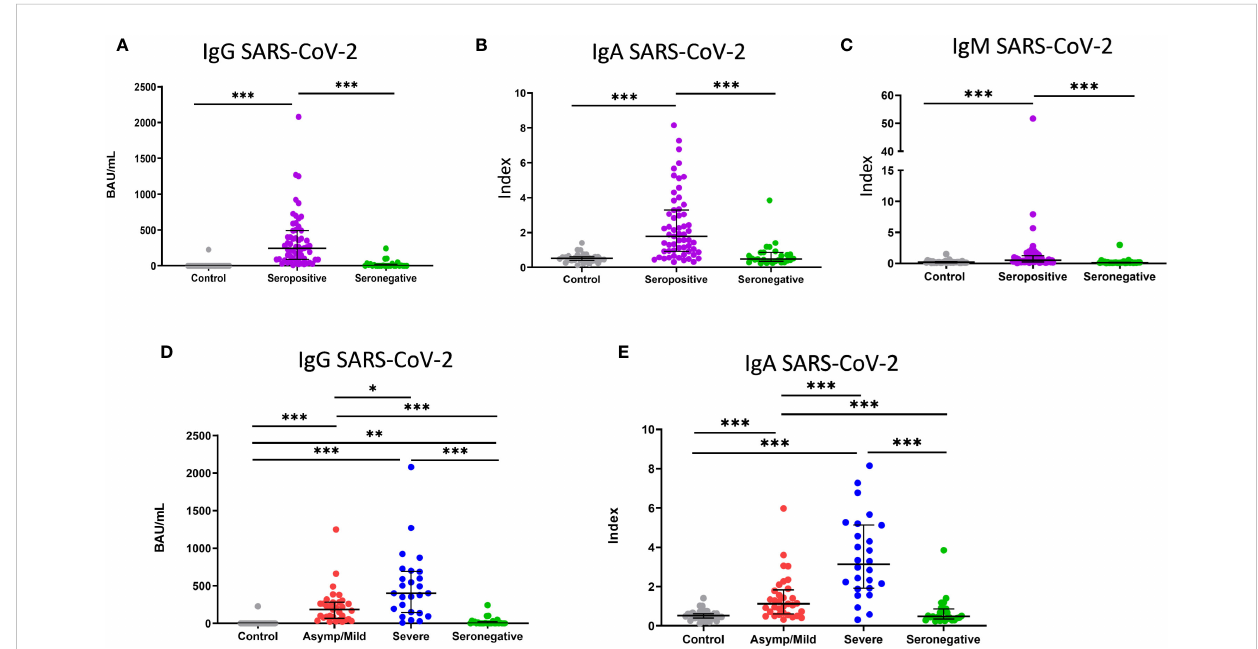
FIGURE 1 Level of IgG, IgA and IgM antibodies against SARS-CoV-2. (A) Binding antibody units mL (BAU/mL) of IgG, (B, C) index values of IgA and IgM in healthy controls (grey dots; n=33), seropositive patients (purple dots; n=59) and seronegative patients (green dots; n=27). (D) Binding antibody units per mL (BAU/mL) of IgG and (E) index value of IgA in healthy controls (grey dots; n=33) and asymptomatic/mild seropositive (red dots; n=33), severe seropositive (blue dots; n=26) and seronegative (green dots; n=27) patients. Each dot represents an individual. Median and IQR are shown. The Mann – Whitney U test was used. *<0.05, **<0.01, ***<0.001. Asymp/mild: asymptomatic or mild